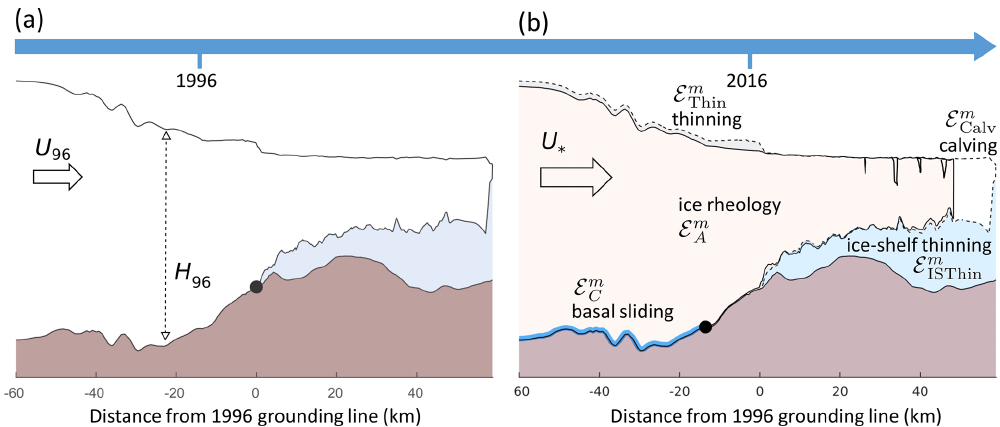
Figure 2. Overview of changes along the Pine Island Glacier centreline from (a) year 1996 to (b) year 2016. Increased ice flow is driven by a combination of calving, ice shelf thinning, and dynamic thinning with movement of the grounding line, as well as changes in basal sliding and ice rheology. Transects of the geometry are based on observations along the flow line indicated in Fig. 1; black dots indicate the respective grounding line positions in both years. Crevasses are introduced for illustration purposes only and do not strictly correspond to observed features. The importance of each “driver of change” was investigated in a series of numerical perturbation experiments, denoted by E m ∗ in panel (b) , with m indicating the sliding exponent and ∗ the respective experiment described in Sect.